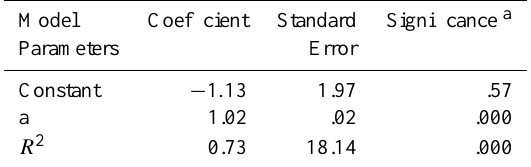
Table 2. Analysis of MUTOP (predicted from regression described in Table 1) against TES (observed), for the 25% of data held in reserve for evaluation (considers TES to be dependent variable).